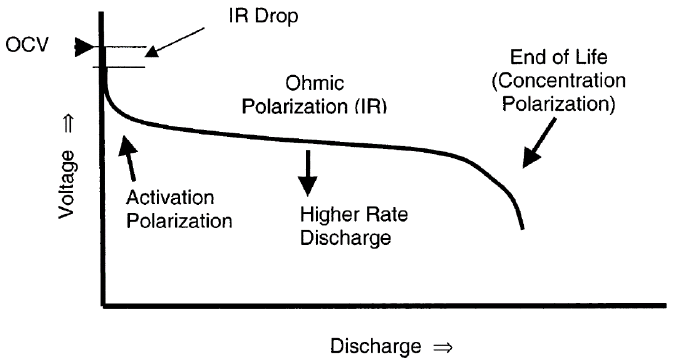
Figure 5. The discharge curve of a battery and the effects of different types of polarization. Adapted with permission from [20], © American Chemical Society, 2004.